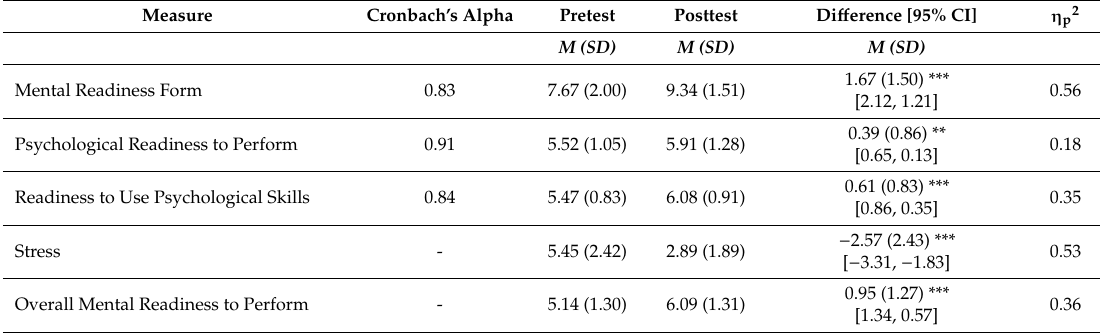
Table 1. Study 1 Descriptive and Inferential Statistics and Measures of Internal